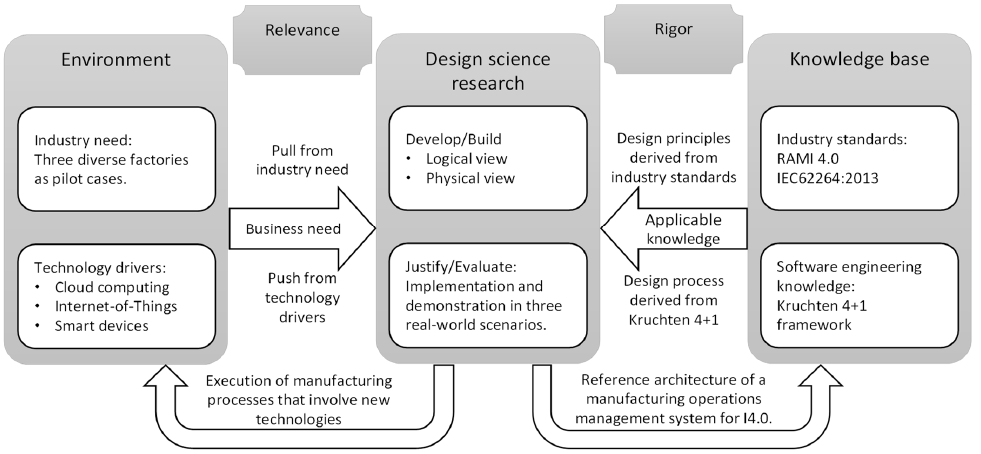
Figure 2. Research framework used in the HORSE Project.